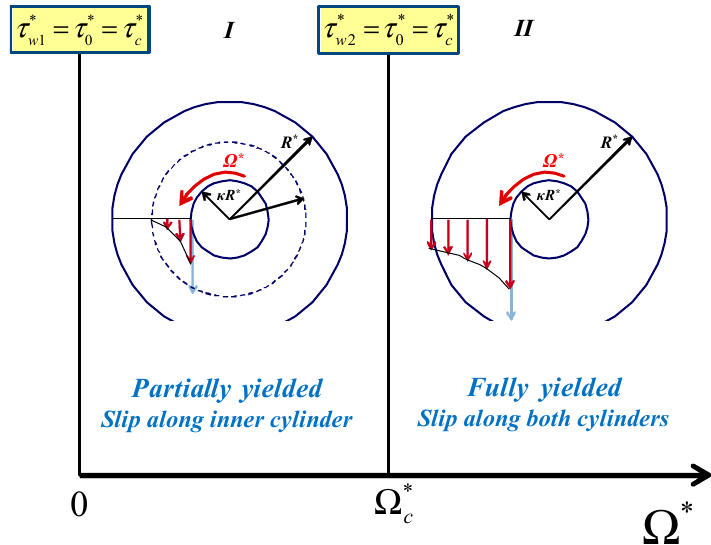
Figure 9. Flow regimes in circular Couette flow of a Bingham plastic in the presence of wall slip with non-zero slip yield stress, when τ ∗ c = τ ∗ 0 . The inner cylinder is rotating and the outer one is at rest.